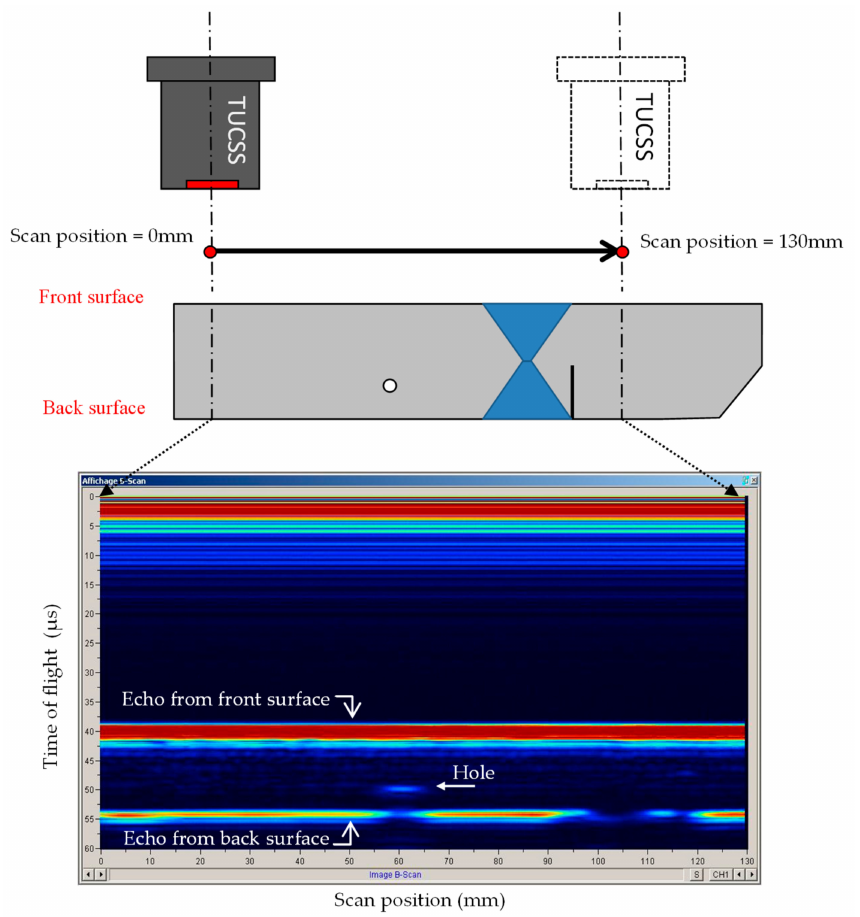
Figure 6. Normal incidence